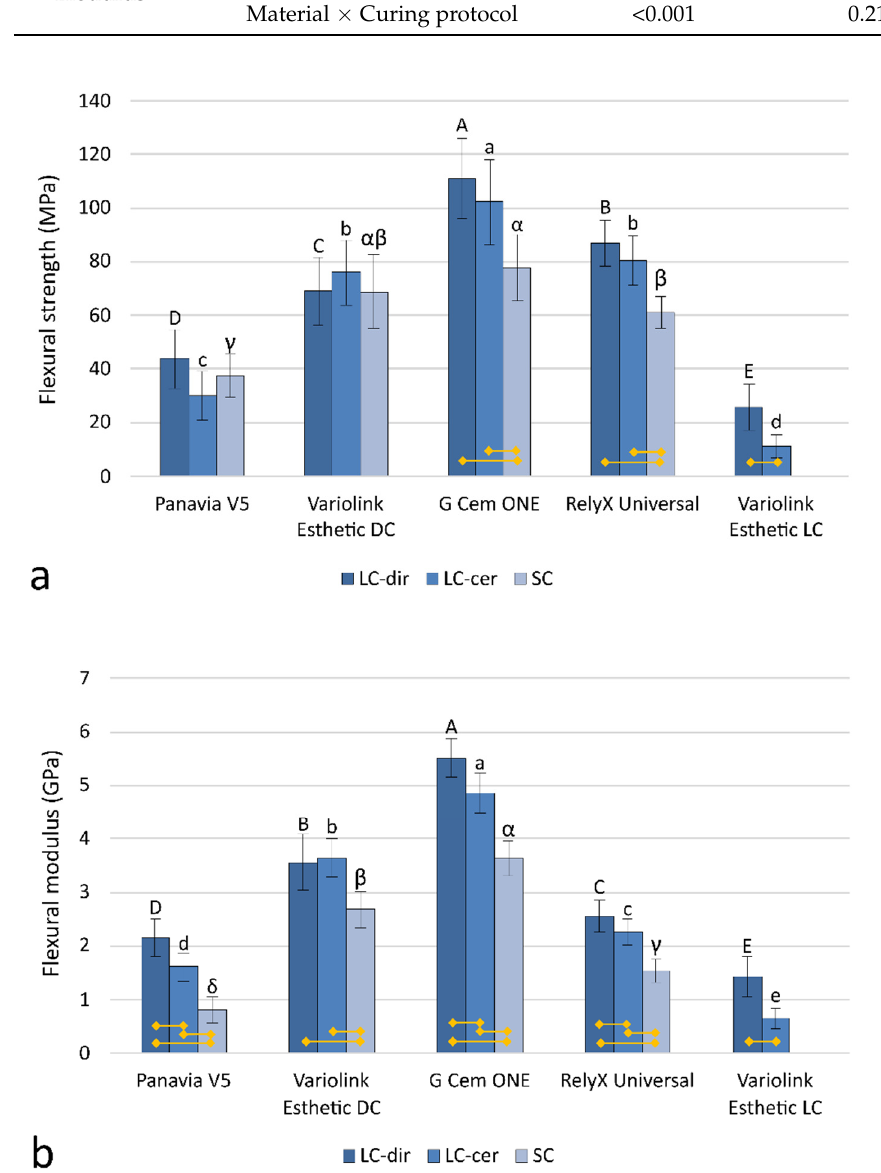
Figure 2. Flexural strength ( a ) and modulus ( b ) represented as mean values ± 1 standard deviation, measured after 28 days in distilled water followed by artificial aging via 7-day immersion in absolute ethanol for the following curing protocols: LC-dir—light-cured directly, LC-cer—light-cured through a ceramic layer, SC—self-cured. Yellow lines at the bottom of the plot denote statistically significant differences among curing protocols. The results of inter-material comparisons within individual curing protocols (LC-dir, LC-cer, and SC) are represented by uppercase, lowercase, and Greek letters,